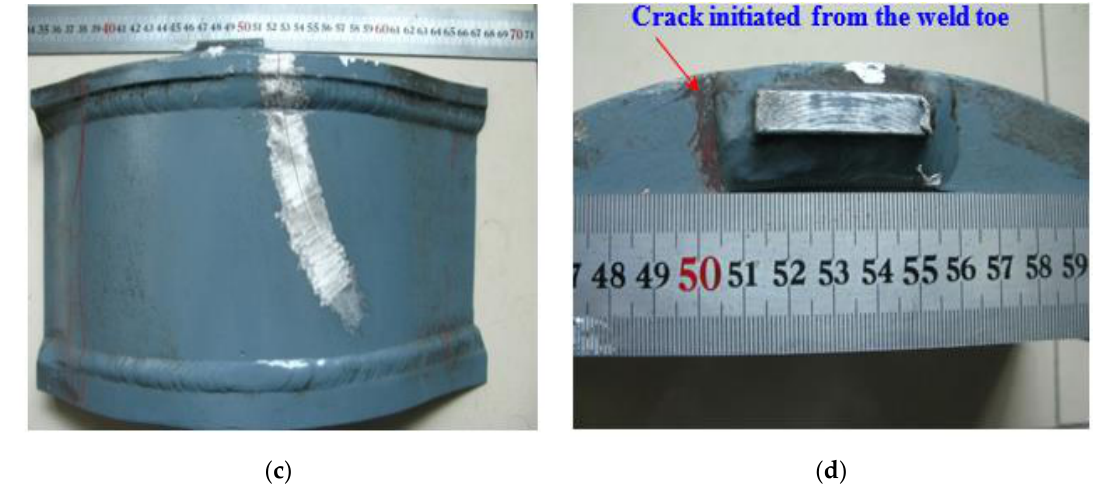
Figure 1. The crack position and the Macro morphology of the crack: ( a ) the crack position found in site; (b) the model of bogie frame and the positioning block; ( c ) and ( d ) the macro pictures of crack initiated from the weld toe of positioning block.